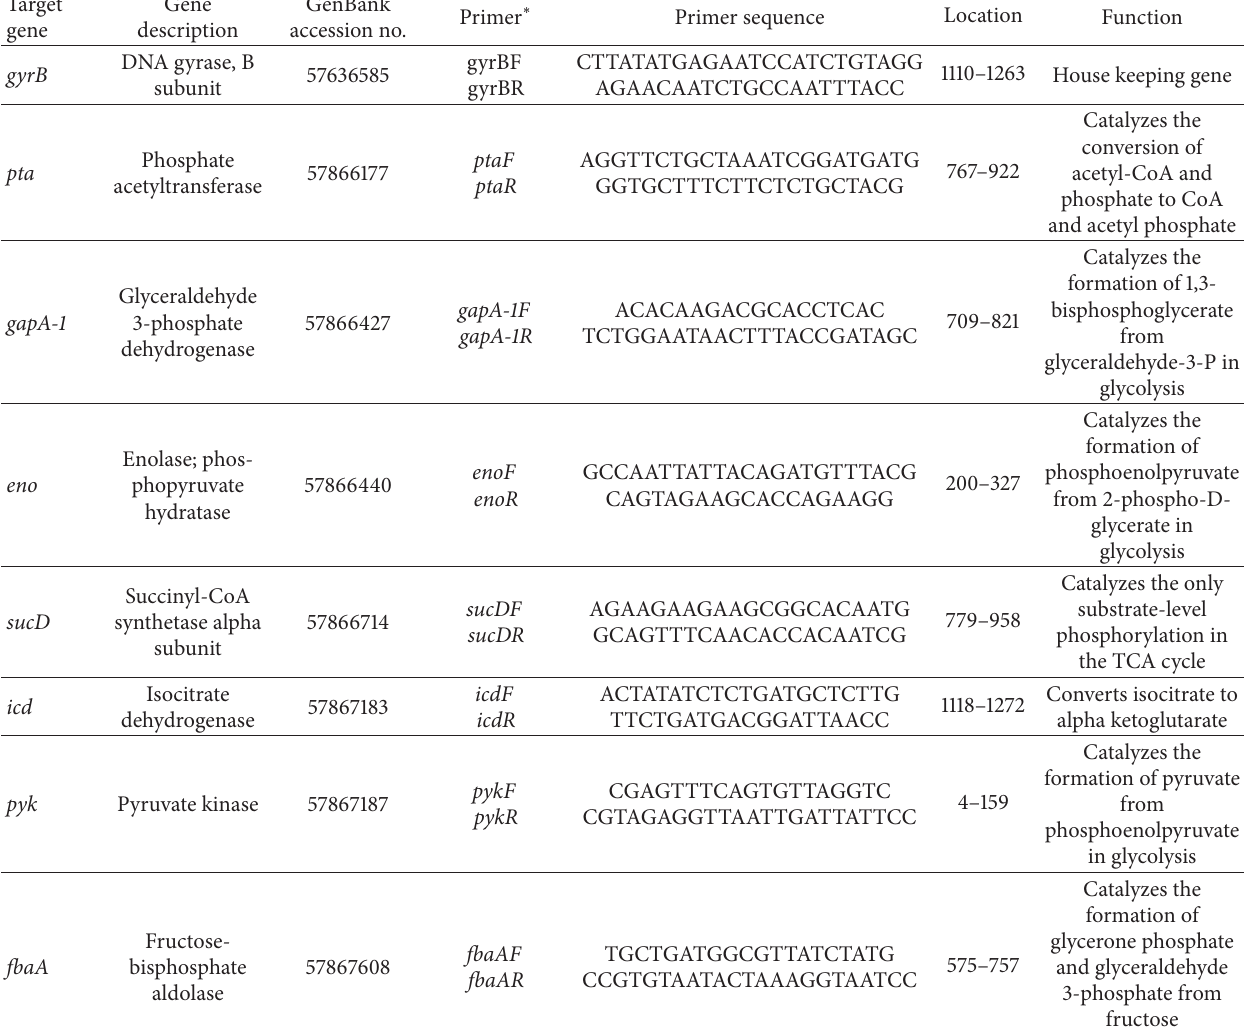
Table 1: Oligonucleotide primers used for RT real-time